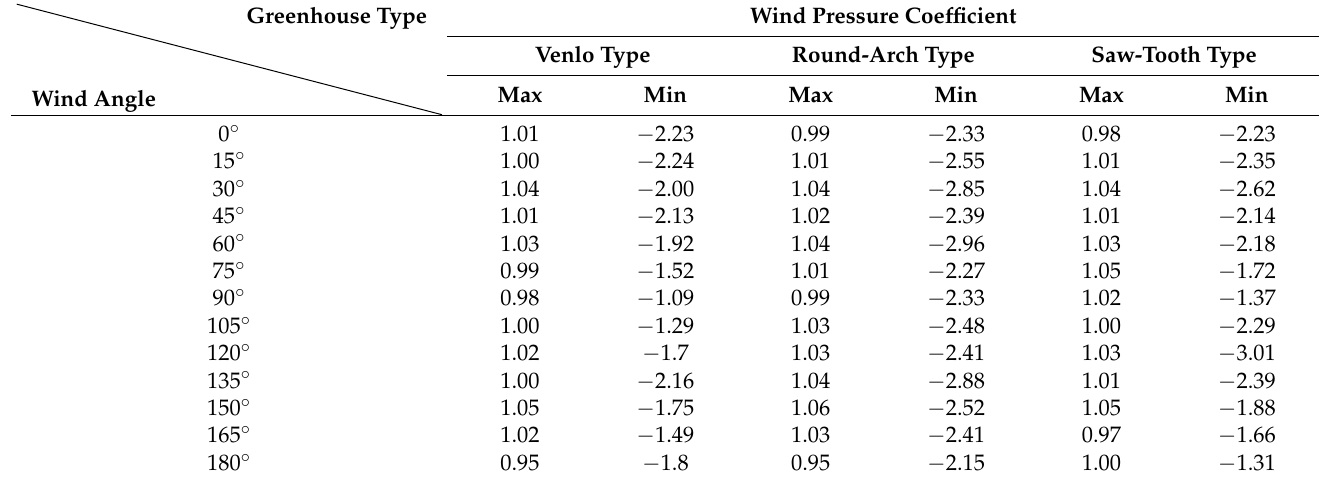
Table 5. Extreme values of wind pressure coefficients for the respective greenhouse type at different wind angles in roof and sidewalls.